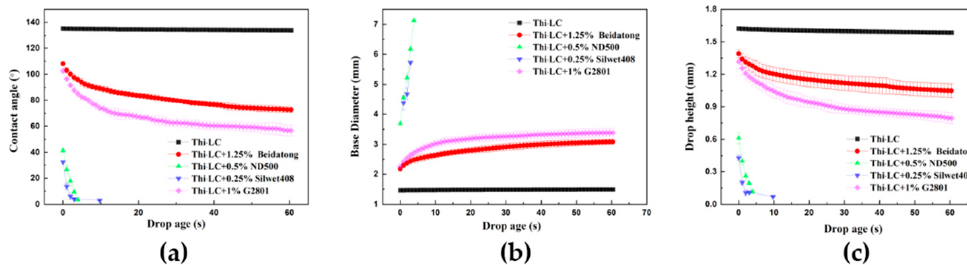
Figure 4. Changes in droplet contact angle ( a ), droplet height ( b ), and droplet contact diameter ( c ) on wheat leaves within the